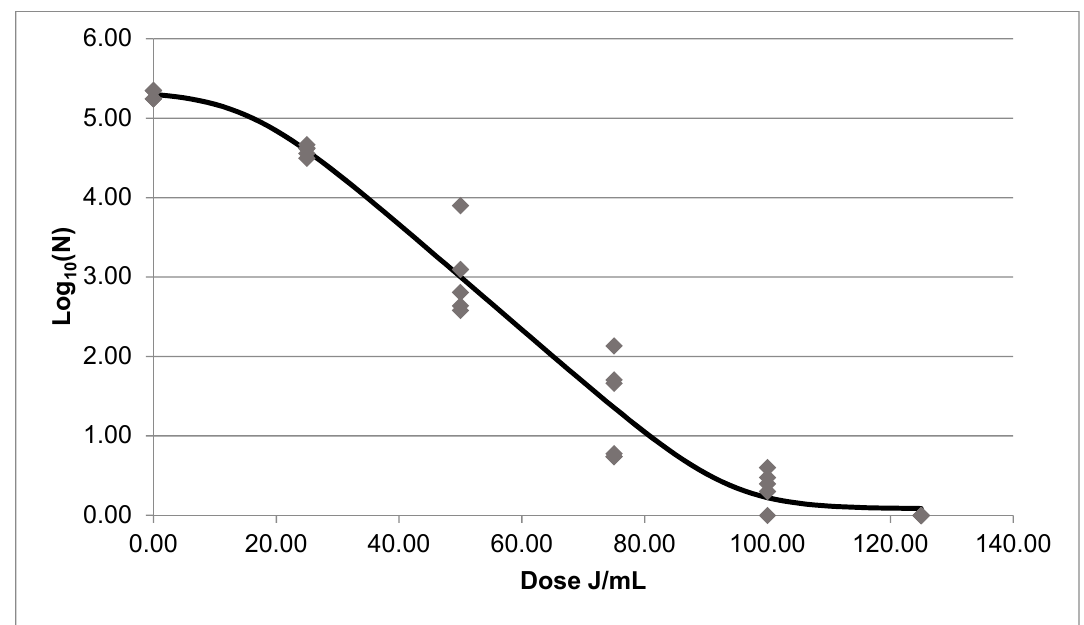
Figure 3. Inactivation kinetics of A. acidoterrestris in cloudy apple juice treated by UV-C with recirculation according to Geeraerd shoulder tail model obtained by using GInaFIT plug-in.